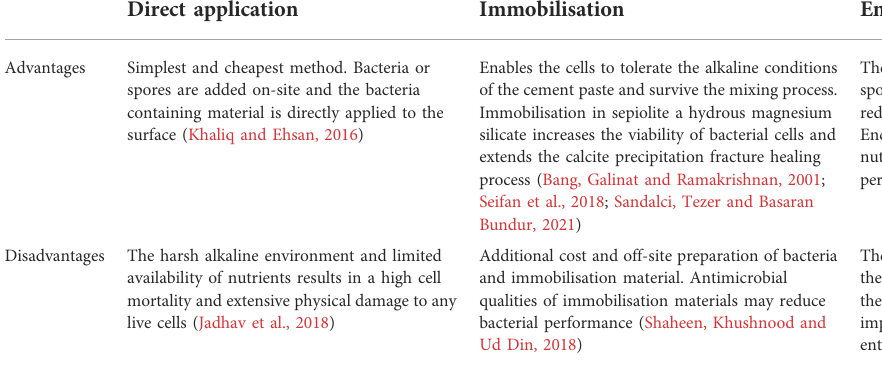
TABLE 2 Comparison of three methods employed to inoculate cement paste with